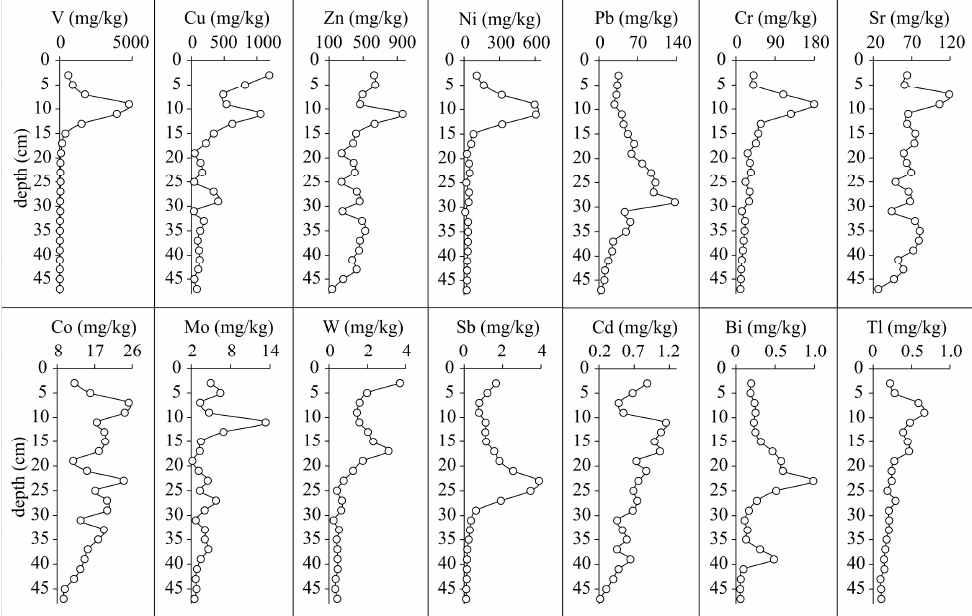
Figure 11. The vertical distribution of heavy metals in sediments of Lake Lamba (the Republic of Karelia) [55].